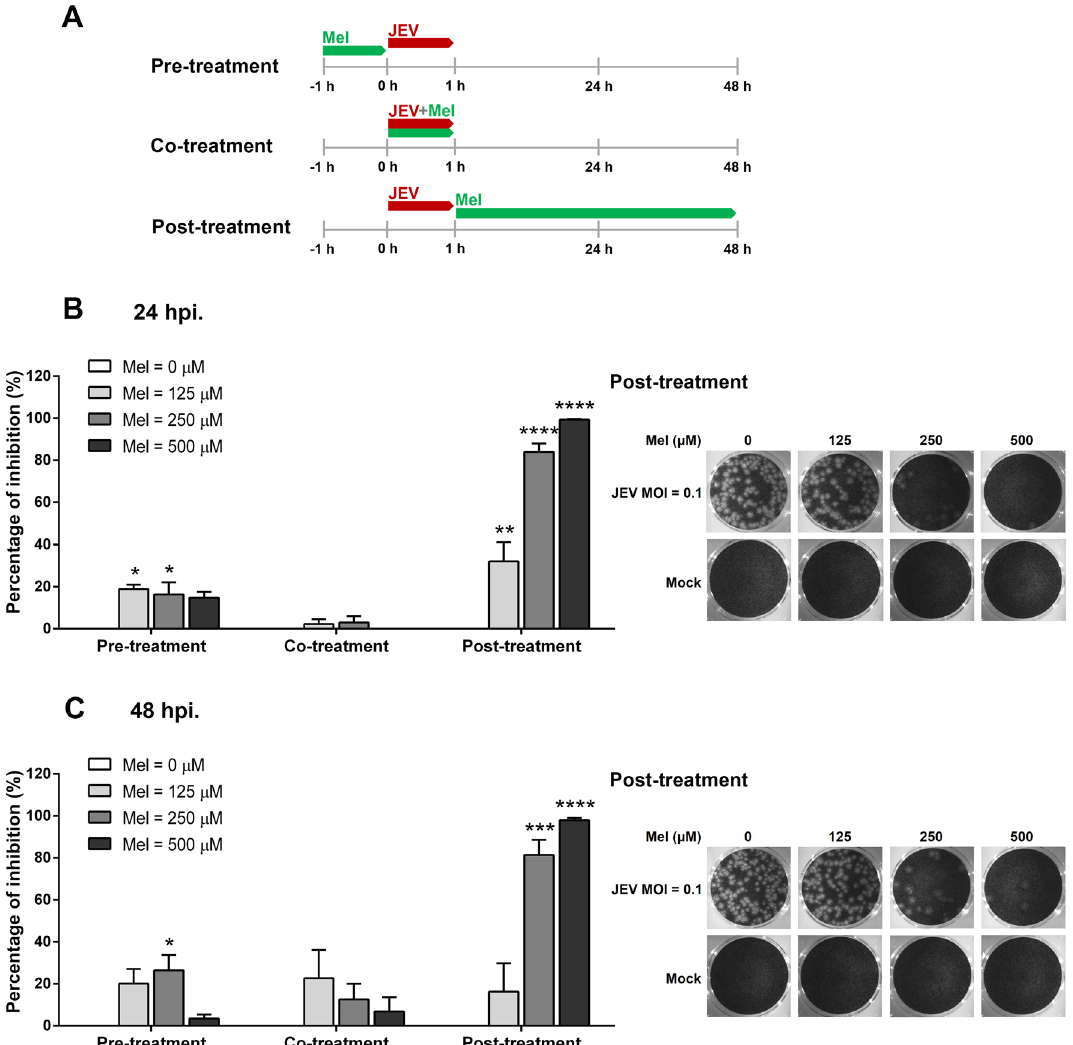
Figure 4. Time-of-addition experiments of melatonin (Mel) on Japanese encephalitis virus (JEV)-infected SH-SY5Y cells. ( A ) Schematic representation of the experimental design. The red line refers to the JEV absorption period and green line refers to the period when the cells were incubated with melatonin. Cells were infected with 0.1 MOI of JEV. Following melatonin treatment regimens were compared: (1) pre-treatment with melatonin for 60 min prior to JEV infection; (2) co-treatment with melatonin during JEV infection; (3) post-infection treatment with melatonin after JEV infection. Cells that were not treated with melatonin served as a control of virus infection. The viral titers were determined by plaque assay of cell culture supernatant and expressed as percentage inhibition at ( B ) 24 hpi and ( C ) 48 hpi. Representative plaque formation results from a post-infection treatment experiment is shown. The graphs show the means ± SD of three independent experiments in technical triplicates. One-way ANOVA and Tukey–Kramer multiple comparisons tests were performed for statistical analysis. * p < 0.05, ** p < 0.01, *** p < 0.001 and **** p < 0.0001, compared to the control without melatonin treatment (0